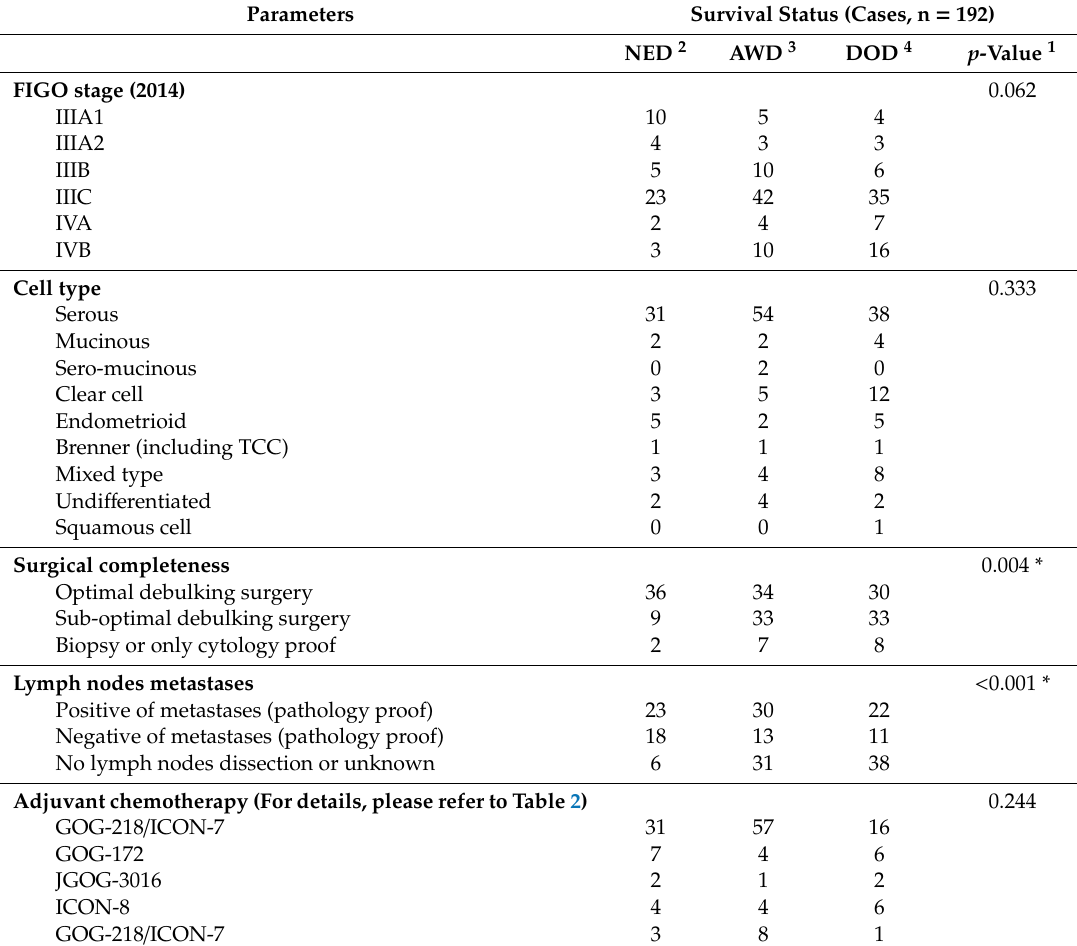
Table 5. Parameters a ff ect survival status in all enrolled cases.